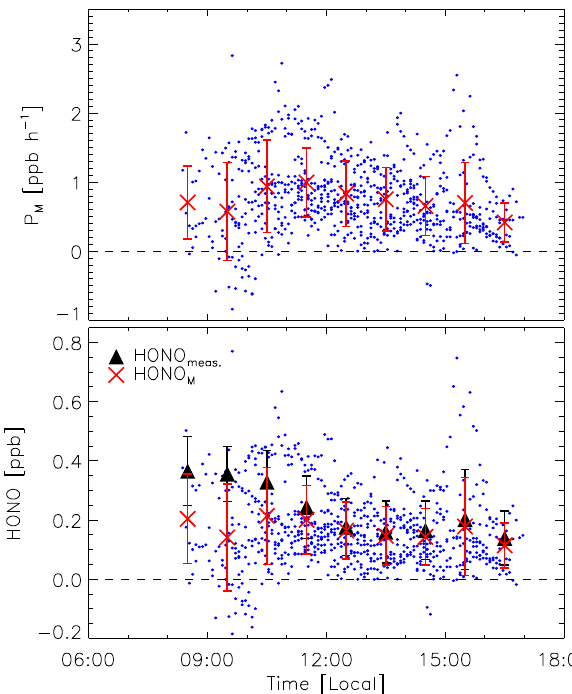
Fig. 8. Upper frame: Calculated additional HONO production rate P M (Eq. 4). The blue dots correspond all 5-min averages where measurements of J HONO , OH, NO and HONO were present. The red circles refer to the mean over 1h with 1- σ error bars. Lower: additional HONO concentration HONO M (Eq. 5). Red circles are the mean values over 1h, black triangles are the mean value of the measured